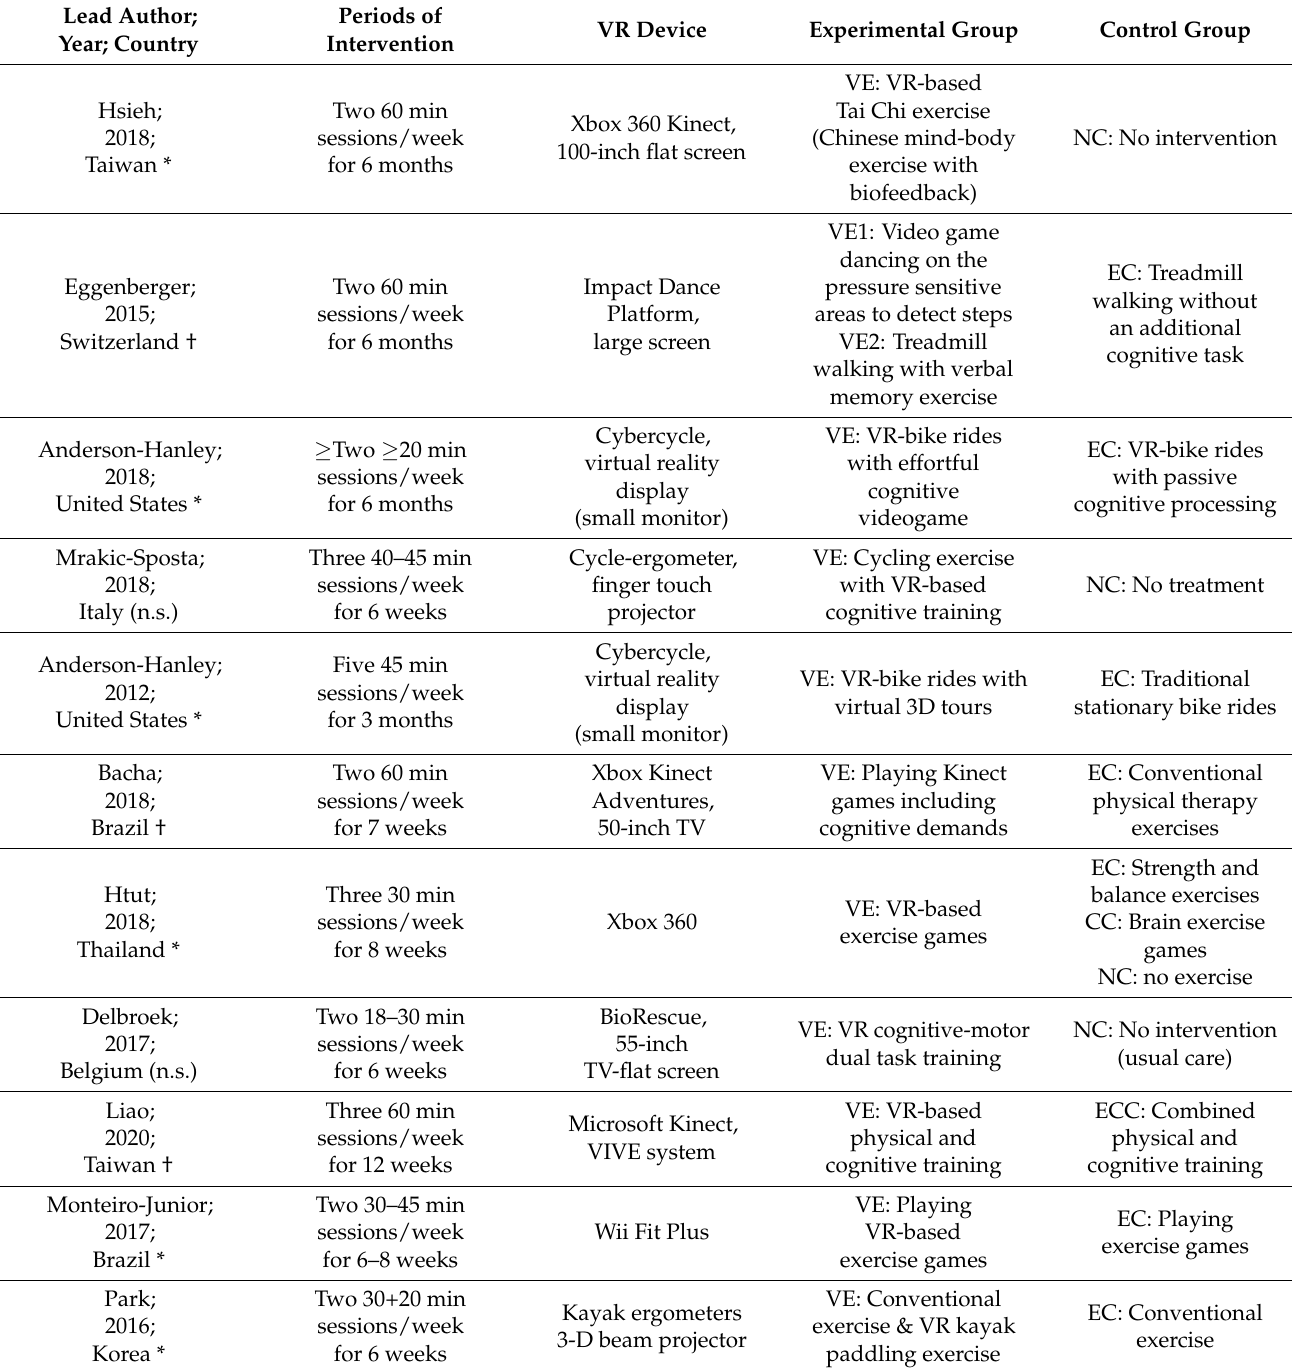
Table 3. Characteristics of intervention methods in the included